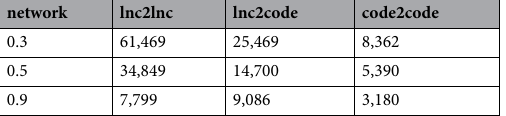
Table 4. Construction of the three networks under different